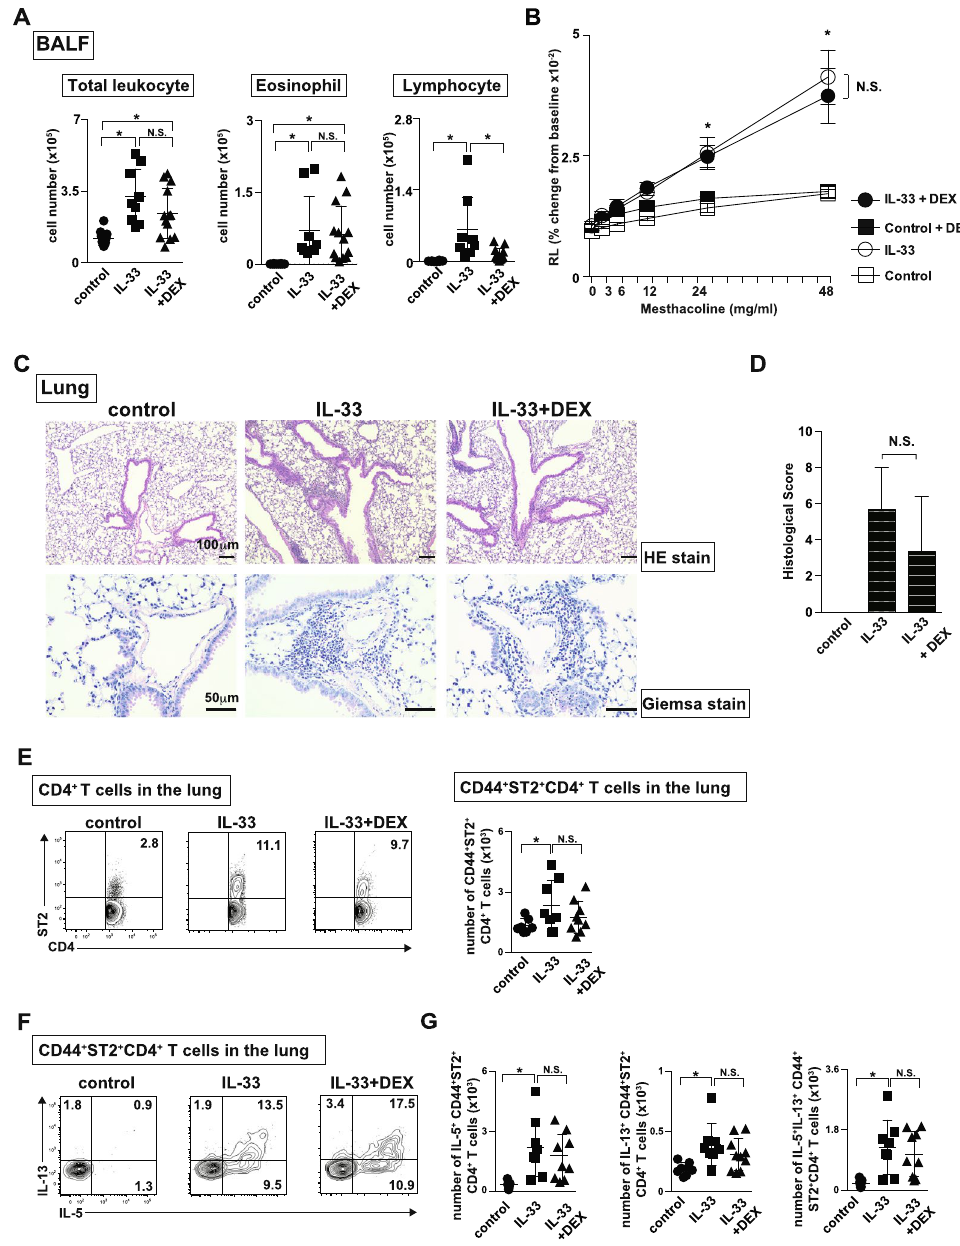
Figure 5. CD44 + ST2 + CD4 + T cells showed steroid-resistance. IL-33 or saline (control) was administered intratracheally to BALB/c mice on Day 0 followed by intra-peritoneal administration of dexamethasone from Days 1 to 3. The indicated assays were performed on Day 10 or Day 14. ( A ) Cell numbers of total leukocytes (left), eosinophils (middle), and lymphocytes (right) in the BAL fluid are shown. The mean values ± SD are shown for three to five mice in each group. ( B ) Lung resistance (RL) was assessed in response to the increasing doses of methacholine. The mean values (four mice per group) are shown with SDs. * p < 0.05: one-way ANOVA. N.S. means not significant. ( C ) Representative histology of the lungs from mice as in A , fixed and stained with hematoxylin and eosin reagent (upper panels) or Giemsa reagent (lower panels). Scale bars: 100 μ m in upper panel, 50 μ m in lower panel. ( D ) Histological scores from Giemsa-stained samples are depicted. ( E ) Representative flow cytometry plots of ST2 + CD4 + cells in the lung and spleen (left). Absolute numbers of CD44 + ST2 + CD4 + T cells in the lung from three groups are depicted. The mean values ± SD are shown for three to five mice in each group. ( F ) Representative intracellular staining profiles of IL-5 and IL-13 in CD44 + ST2 + CD4 + T cells. ( G ) Absolute numbers of indicated cytokine-producing CD44 + ST2 + CD4 + T cells in the lung from three groups are depicted. The mean values ± SD are shown for three to five mice in each group. Three independent experiments were performed, and similar results were obtained. * p < 0.05: one-way